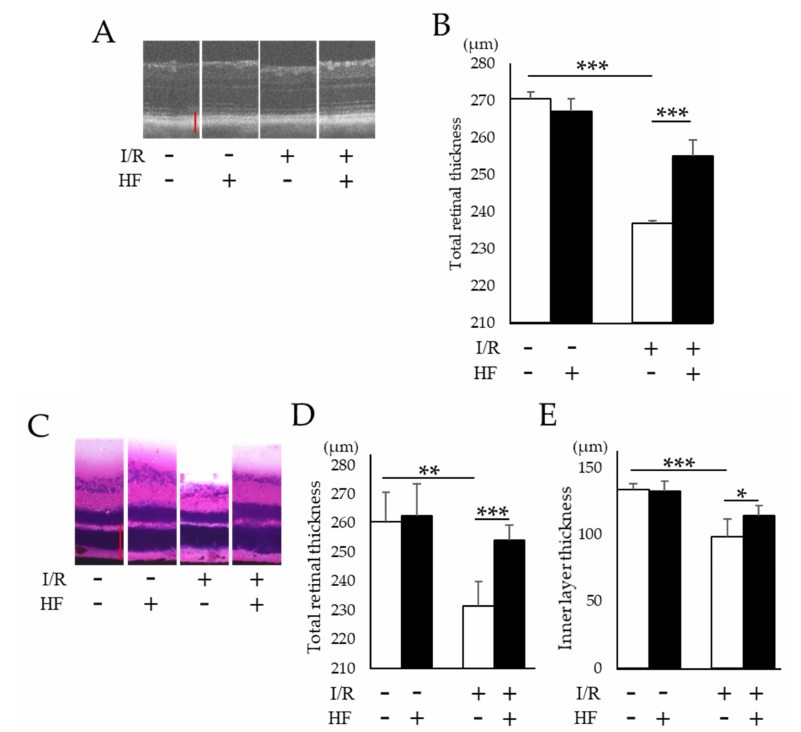
Figure 4. Evaluation of retinal morphology. ( A ) Representative optical coherence tomography (OCT) images of each group. Scale bar; 100 μ m. ( B ) The average of total retinal thickness measured in OCT ( n = 4). Note that the decreased total retinal thickness was prevented by halofuginone treatment post-I/R injury. ( C ) Representative H&E stained retinal sections. Scale bar; 100 μ m. ( D ) The average of the total retinal thickness measured in H&E stained sections ( n = 5). ( E ) The average of the inner retinal thickness in H&E stained retinas ( n = 5). Note that the decrease of the thickness was found remarkably in inner retinal layers, whereas those changes were suppressed by halofuginone administration. HF; halofuginone. Error bars indicate the standard deviation. * p < 0.05, ** p < 0.01, *** p < 0.001, Student’s t -test.